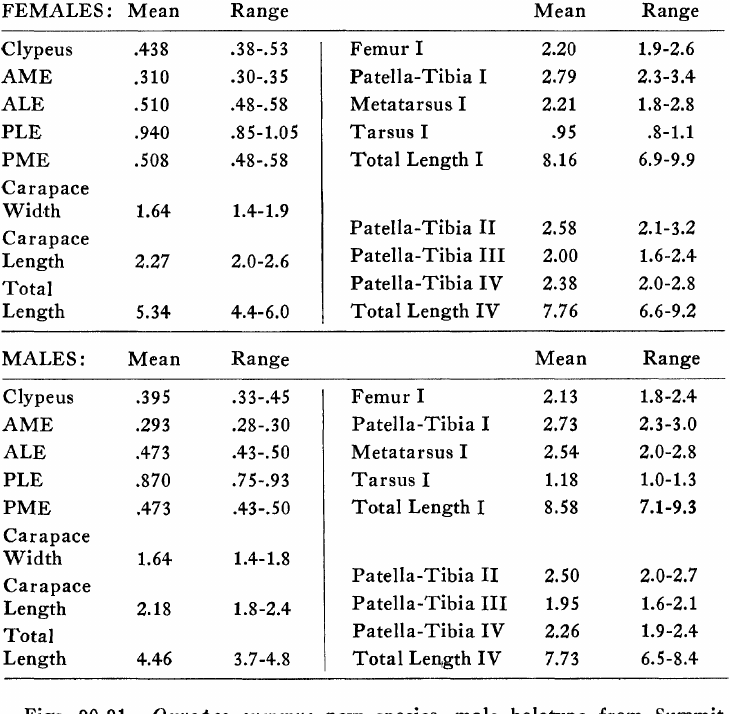
Figs. 90-91. Oxyopes summus new species, male holotype from Summit, Panama Canal Zone, 21-29 July 1950. 90. Left palpus, retrolateral view. 91. Left palpus, ventral view. Figs. 92-93. Oxyopes chiapas new species, male holotype from La Zacualpa, Chiapas, Aug. 1909. 92. Retrolateral view. 93. Ventral view. Figs. 94-95. Oxyopes Iibialis F.O.P.-Cambridge, male from E of Tela, Honduras, 26 July 1929. 94. Retrolateral view. 95. Ventral view. Figs. 96-97. Oxyopes tibialis F.O.P.-Cambridge, male lectotype from Guatemala. 96. Retrolateral view. 97. Ventral view. Scale on left, below is for Figs. 90-95. Scale on right, above is for Figs.